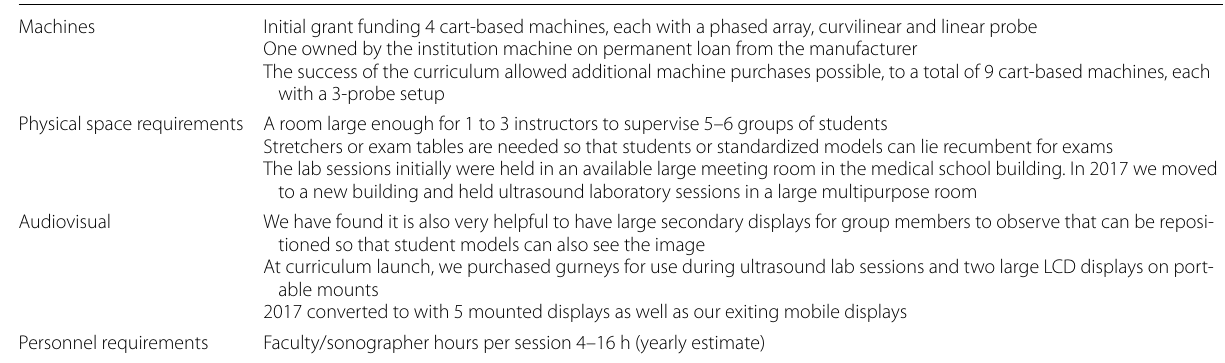
Table 5 Infrastructural details of program development at wake forest school of medicine